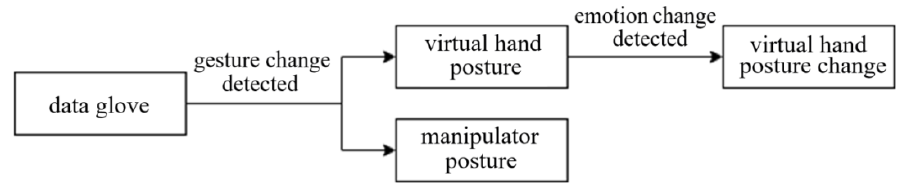
Figure 9. The technological process of the system that virtual gesture change driven by emotion. The virtual hand model comes from network shared resources. The fingers of index finger, middle finger, ring finger, and little thumb have 5 movable joint points, respectively, and the thumb has four movable joint points. There are 24 movable joint points for changing the gesture of the hand, as shown in Figure 10.